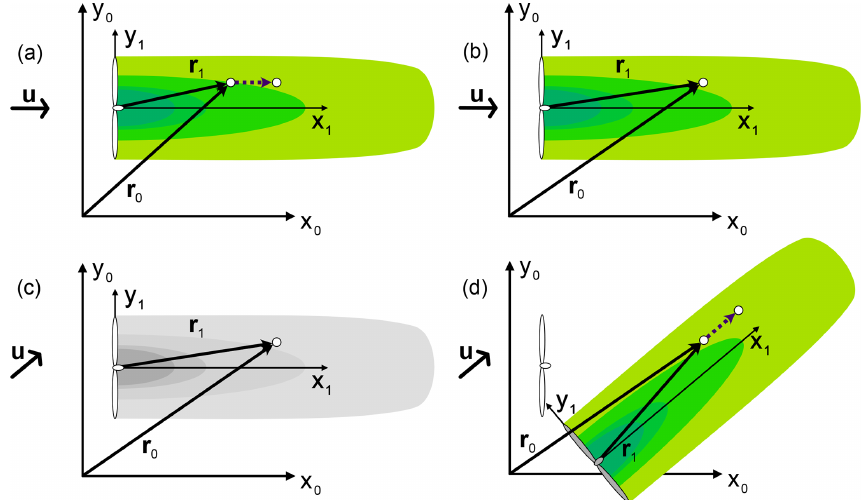
Figure 3. This figure visualizes the working of Eq. (9), which is applied for each OP individually. In panels (a) and (b) , the position update of an OP in a time step with a constant wind direction is depicted. Panels (c) and (d) show the position update when the wind direction changes. In this case, the wake coordinate system is rotated around the OP’s location to match the new downstream direction. This causes the apparent origin of the wake in the world coordinate system to change, which is visualized by the grey